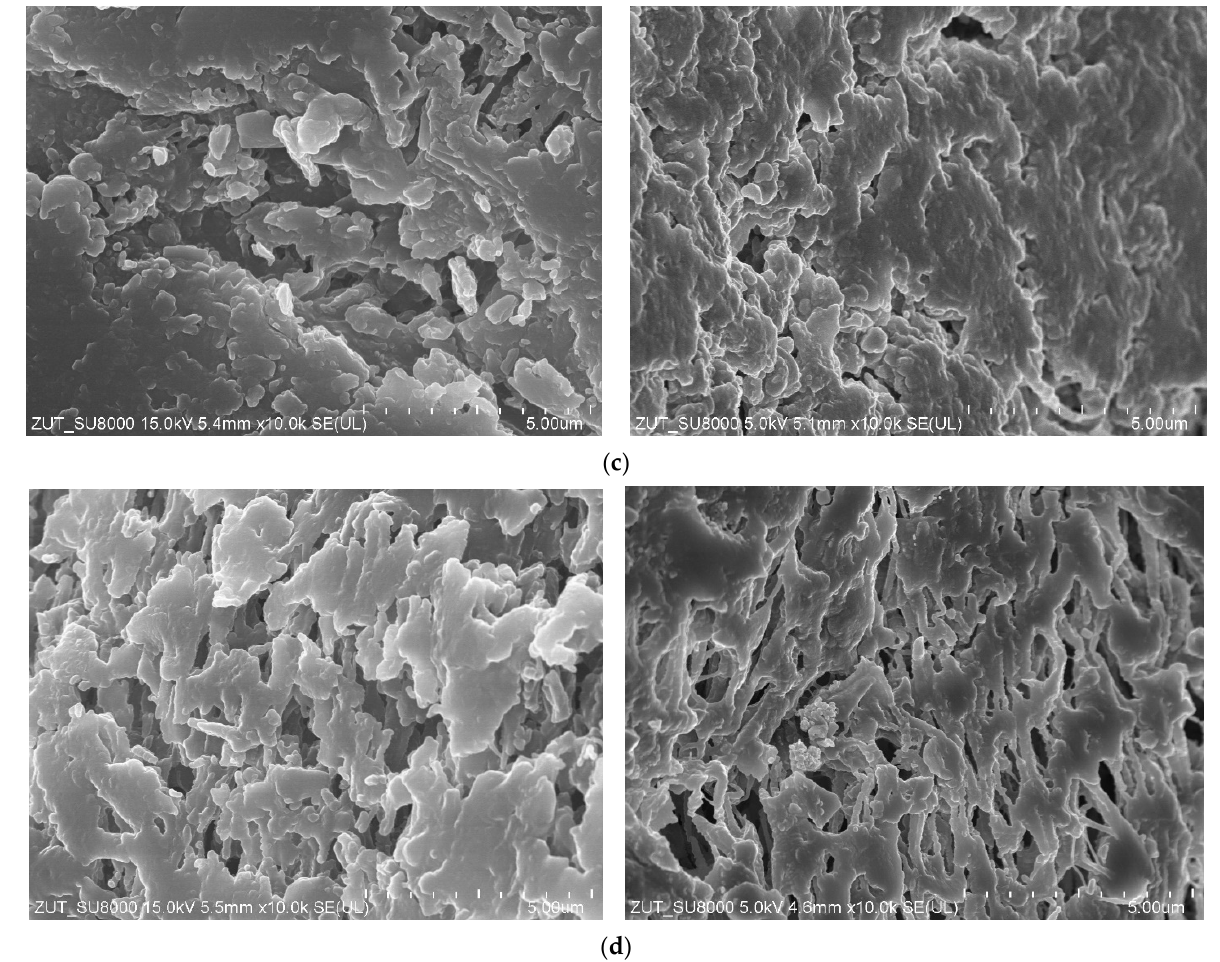
Figure 15. SEM images of membrane samples before (the left side) and after the MD process (the right side). Membranes: ( a ) #1, ( b ) #2, ( c ) #5, ( d )